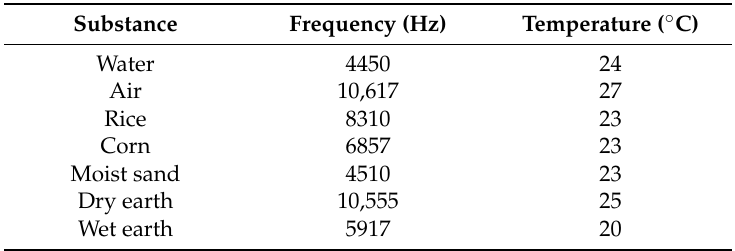
Table 5. Readings average with the probe in different substances.